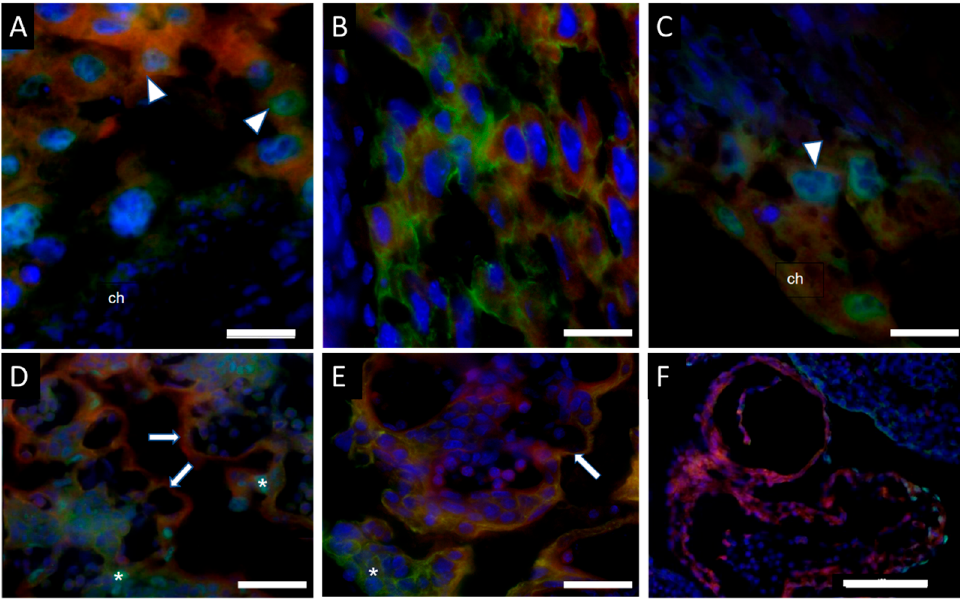
Figure 1. Expression of Nkx2-5-Cre and Hand1 or Cytokeratin 7 in the placenta and fetal heart at embryonic day 8.5 (E8.5), E9.5 and E10.5. ( A ) Nkx2-5 Cre (red) is expressed in trophoblast progenitor cells at E8.5, overlapping with Hand1 protein expression, but not in chorion which does express Hand1. ( B ) Colocalization of Nkx2-5 Cre (red) expression with cytokeratin 7 (green) at E8.5. ( C ) At E9.5, Nkx2-5 Cre (red) and Hand1 (green) are co-expressed in both chorion and labyrinth trophoblast progenitor cells. ( D ) Hand1 (green) and Nkx2-5 Cre (red) overlap in syncytiotrophoblasts of the placental labyrinth, whilst sinusoidal giant cells do not express Nkx2-5 Cre at E10.5. ( E ) Colocalization of Nkx2-5 Cre (red) expression with cytokeratin 7 (green) at E10.5. ( F ) Hand1 is co-expressed in a subset of ventricular cardiomyocytes at E9.5. Arrowhead is trophoblast progenitor cell. Arrow is syncytiotrophoblast. Asterisk is sinusoidal giant cell. ch = chorion. Scale bar = 50 µm ( A – E ) and 100 µm ( F ) .